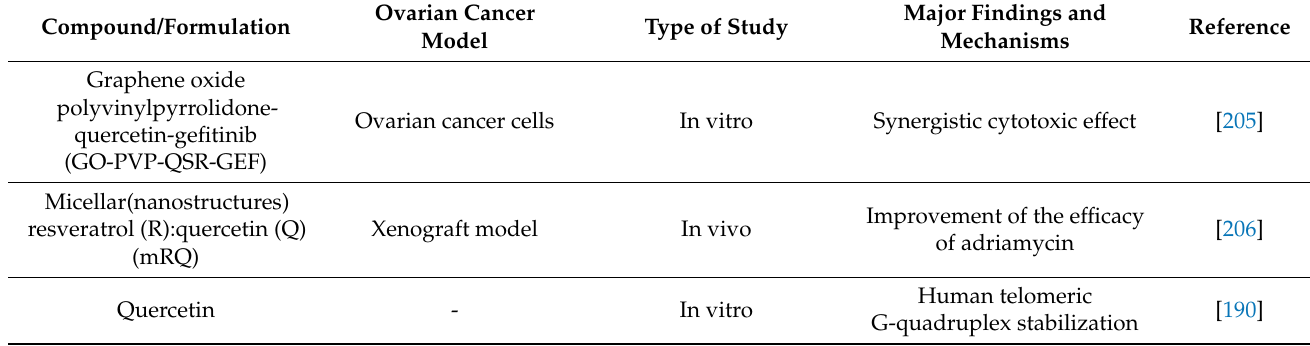
Figure 6. Quercetin targets several signaling pathways within the cells, representing a potential therapeutic agent against ovarian cancer (adapted from [80]). Table 2. Update on experimental data reported in the literature for the activity of quercetin in the ovarian cancer model. This table is intended as an addendum to the ones reported by Shafabakhsh and Asemi [80] and by Vafadar et al. [81], thus updated records were included. The reader is invited to refer to the abovementioned reviews for a more comprehensive overview, with the corresponding references.